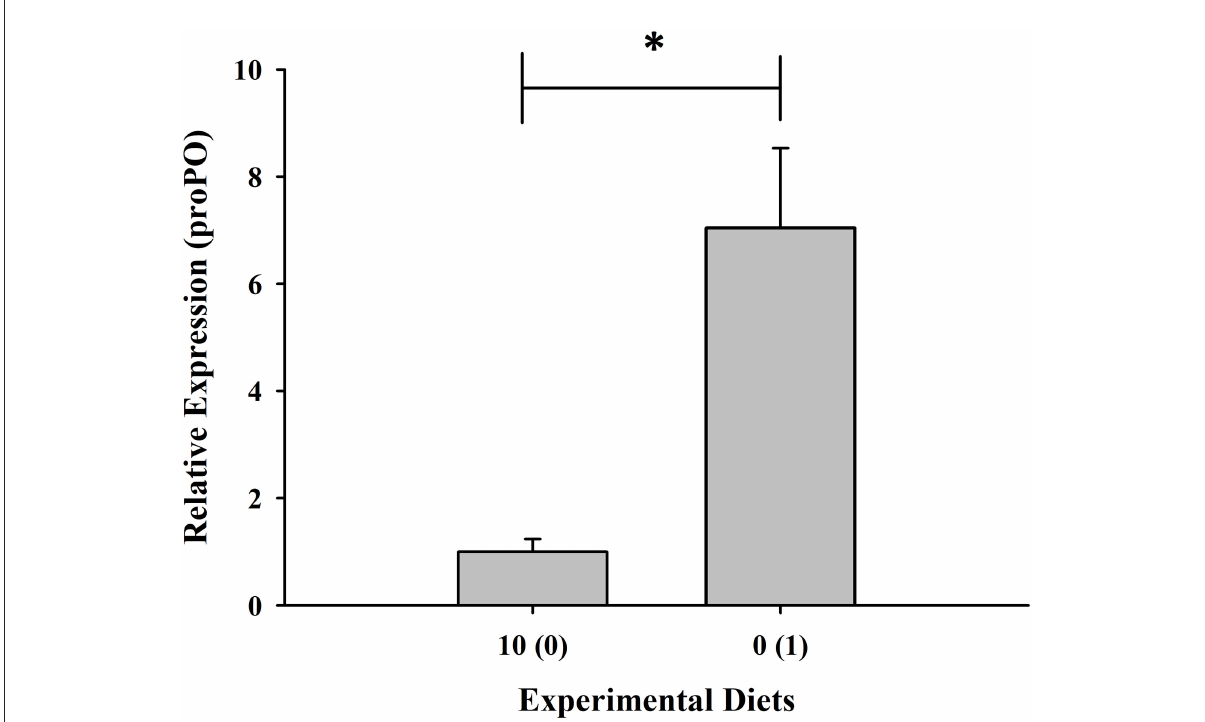
FIGURE6 Relative expression of prophenoloxidase gene of shrimp fed with plant-based diets supplemented with squid by-product hydrolysate. Values are mean ± SEM. The asterisk indicates a significant difference between